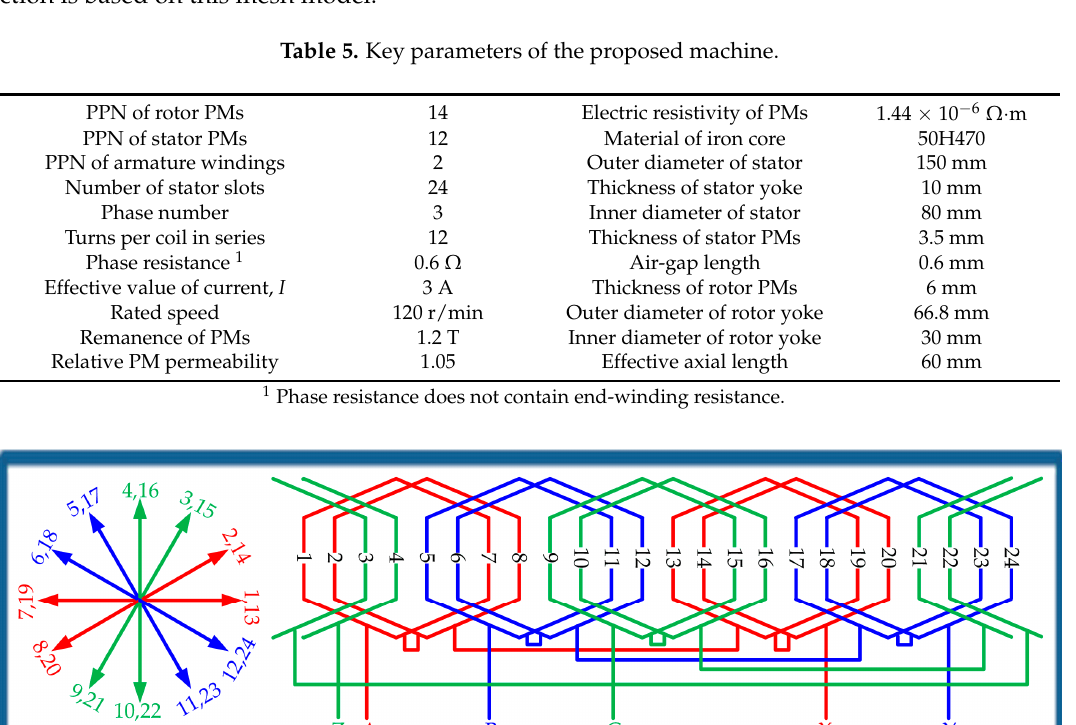
Figure 4. Mesh model of the proposed machine. 4.1. Choice of Optimal Magnetization Pattern As described in Section 2, the radial PMs on stator and the rotor PMs can be magnetized along the same direction or along different directions; in addition, there are also two magnetization patterns for the two tangentially magnetized PMs in the PM array. Thus, there are eight different magnetization patterns for the proposed machine, as illustrated in Figure 5. It can be observed from Figure 5 that row 1 is mirrored to row 2, i.e., the flux will be identical except that the flux direction is reversed. Hence, we just need to study the above magnetization patterns. Figure 6a gives waveforms of single-phase back electromotive forces (back EMFs) when the proposed machine adopts magnetization pattern A, B, C and D. Figure 6b displays corresponding RMS and THD. It